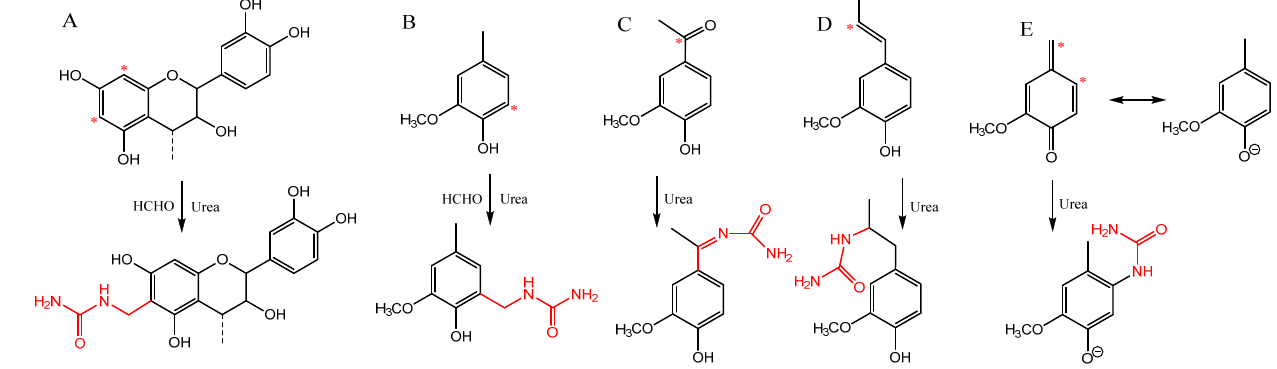
Figure 1. Nitrogen modification of ( A ) tannin and ( B ) lignin aromatic units by Mannich reaction, lignin carbonyls by Schiff base reaction ( C ), Michael addition to ring-conjugated double bonds in lignin side chain ( D ), and Michael addition to quinone methide intermediates in lignin ( E ). Asterisks indicate reactive sites.